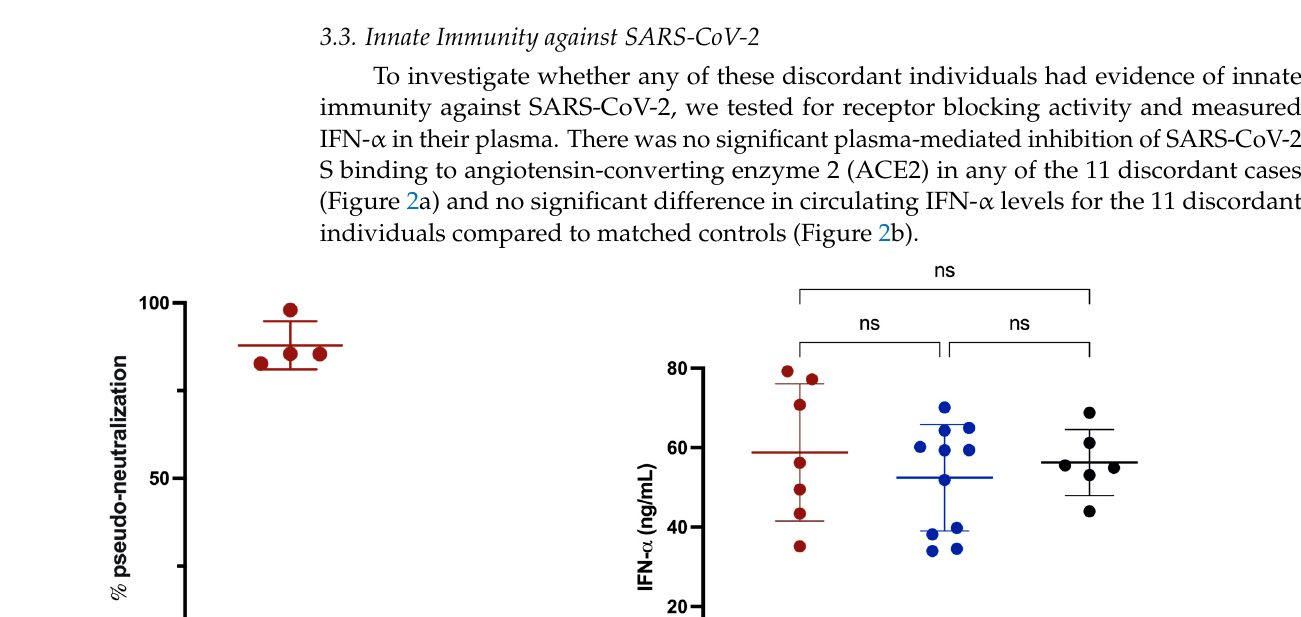
Figure 1. Serological responses of discordant case subjects against SARS-CoV-2 S measured by ELISA. ( a ) IgG antibody responses to SARS-CoV-2 FLS and RBD with plasma samples from previ- ously infected subjects included as positive controls. The horizontal lines represent cut-off values for seropositivity established as 2 SD above the mean OD of control samples collected before Octo- ber 2019. ( b ) IgM antibody response of discordant subjects with plasma samples from previously infected subjects included as positive controls against SARS-CoV-2 FLS. ( c ) IgA antibody response of discordant subjects with plasma samples from previously infected subjects included as positive controls against SARS-CoV-2 FLS and RBD. ( d ) Comparison of IgG antibody responses against SARS-CoV-2 FLS protein following one dose of BNT162b2 mRNA vaccination between previously infected, non-exposed, and 5 discordant individuals (1185, 1340, 1383, 1418, 1637) for whom post- vaccine 1 samples were available. Red and blue shading of dots and bars represents positive con- trols and discordant case subjects respectively. Black dots and the gray shaded bar represent previ- ously unexposed subjects. The probability of a significant difference between groups was calculated using the Mann–Whitney test, with p values or ns (not significant) shown above lines spanning the groups compared.